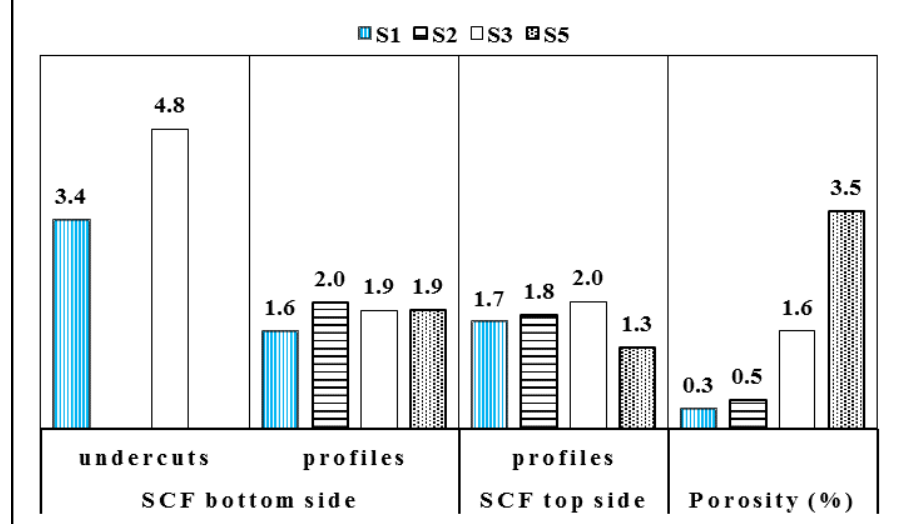
Figure 9. SCFs for undercuts and profiles and porosity percentage of S1, S2, S3 and S5 series.